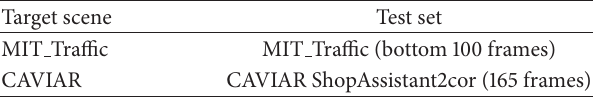
Table 2: The descriptions of the datasets for